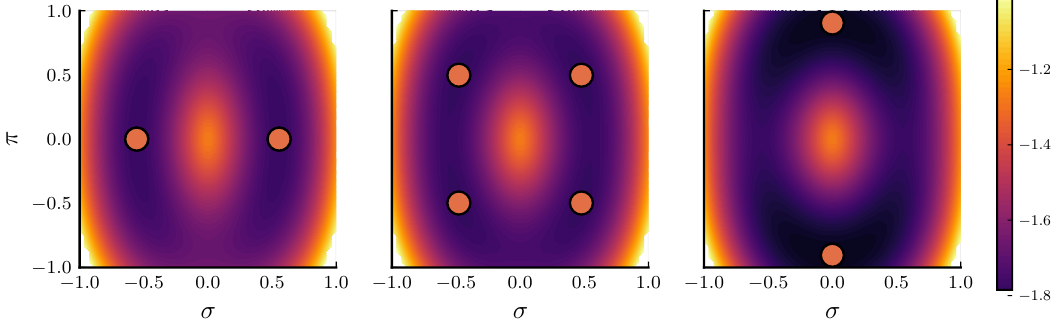
Figure 1 . (The colorscale and y-axis is the same for all three figures). The effective potential V eff ( σ, π ) of the lattice model as a function of σ and π for three different combinations of the coupling constants. All figures have g 2 = 6 . 0 but g 2 is taken from 2 . 6 to 2 . 8 and finally to 3 . 2 . These x y couplings are chosen so that the leftmost figure sits in the bond density wave phase, where the effective potential has two minima with nonzero σ . The second figure represents the coexistence region where both order parameters are nonzero. Note that in this coexistence region the effective potential is close to spherically symmetric even this far away from the continuum limit. Finally, we show the effective potential for a value of g 2 where the minima are found for nonzero π and the y groundstate has a sublattice-polarized fermion